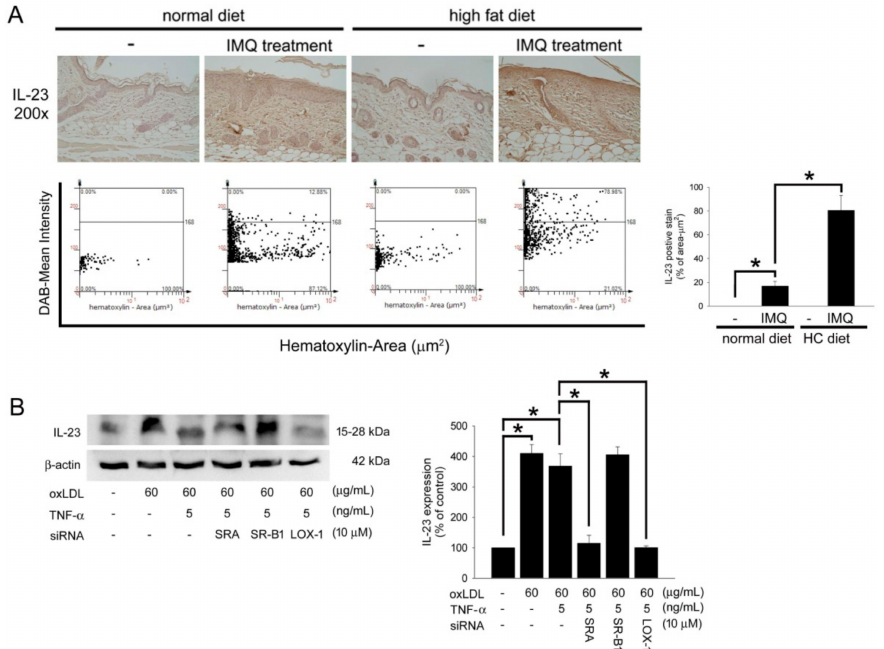
Figure 4. HC-diet aggravated the IL-23 expression in IMQ-treated B6.129S2-Apoe tm1Unc /J mice and oxLDL induced IL-23 expression mediating by LOX-1 in TNF- α -stimulated Hacat cells. ( A ) The representative photos of the mice received IMQ treatment in a normal chow diet or HC-diet groups. The skin slides were stained with anti-IL-23 antibody. The images were acquired at a 200 × magnification and quantified using TissueGnostics TissueFAXS & HistoFAXS System (TissueGnostics, Vienna, Austria). The density of IL-23 expression was presented as a bar graph (right). ( B ) Hacat cells were incubated with oxLDL or oxLDL plus TNF- α for 24 h with or without preincubation of specific competitive scavenger antibodies. Total proteins were extracted and western blot analysis was performed. β -actin was used as a loading control. The density of each band was quantified by a densitometer. All results were expressed as the mean ± SD. A * p < 0.05 was considered statistically